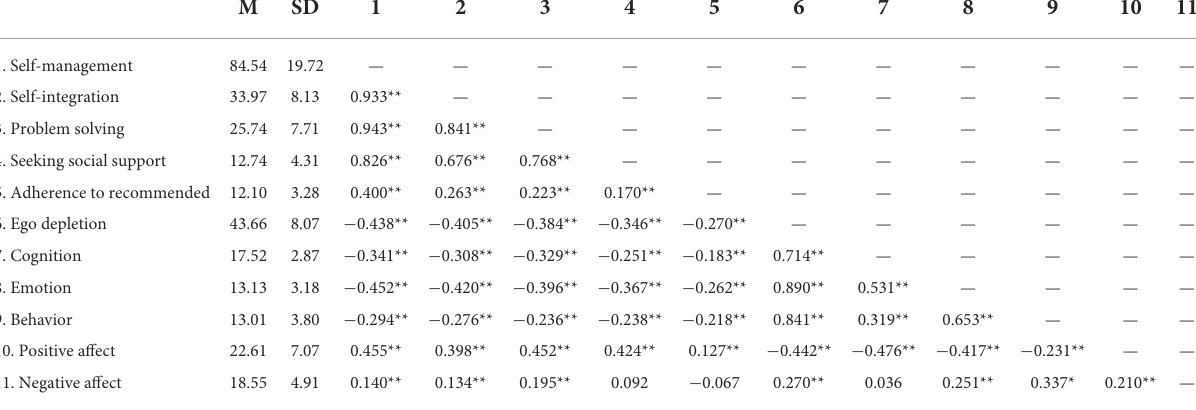
TABLE 2 Pearson correlation analysis of self-management, ego depletion, and positive and negative affect ( n = 383).